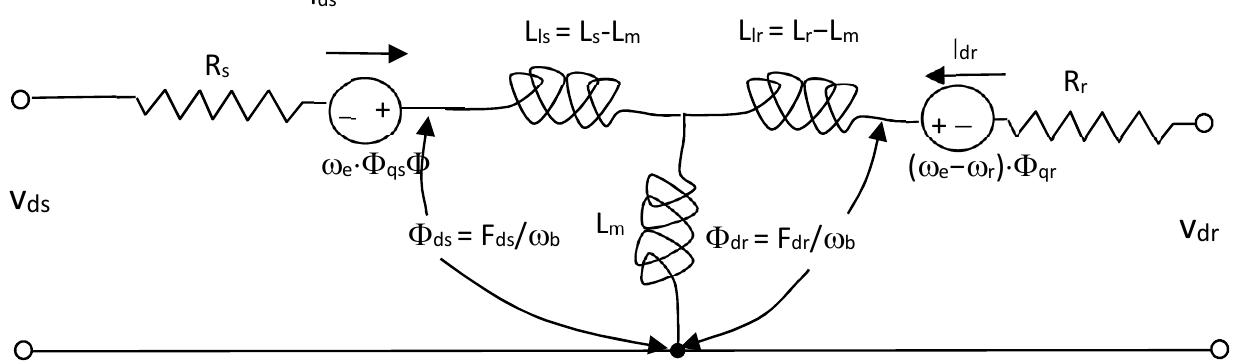
Figure 5. Dynamic equivalent circuit of an IM along the q -axis of the rotating reference system.